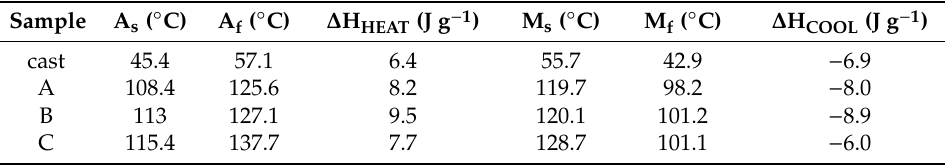
Table 2. Results of DSC analysis of the investigated